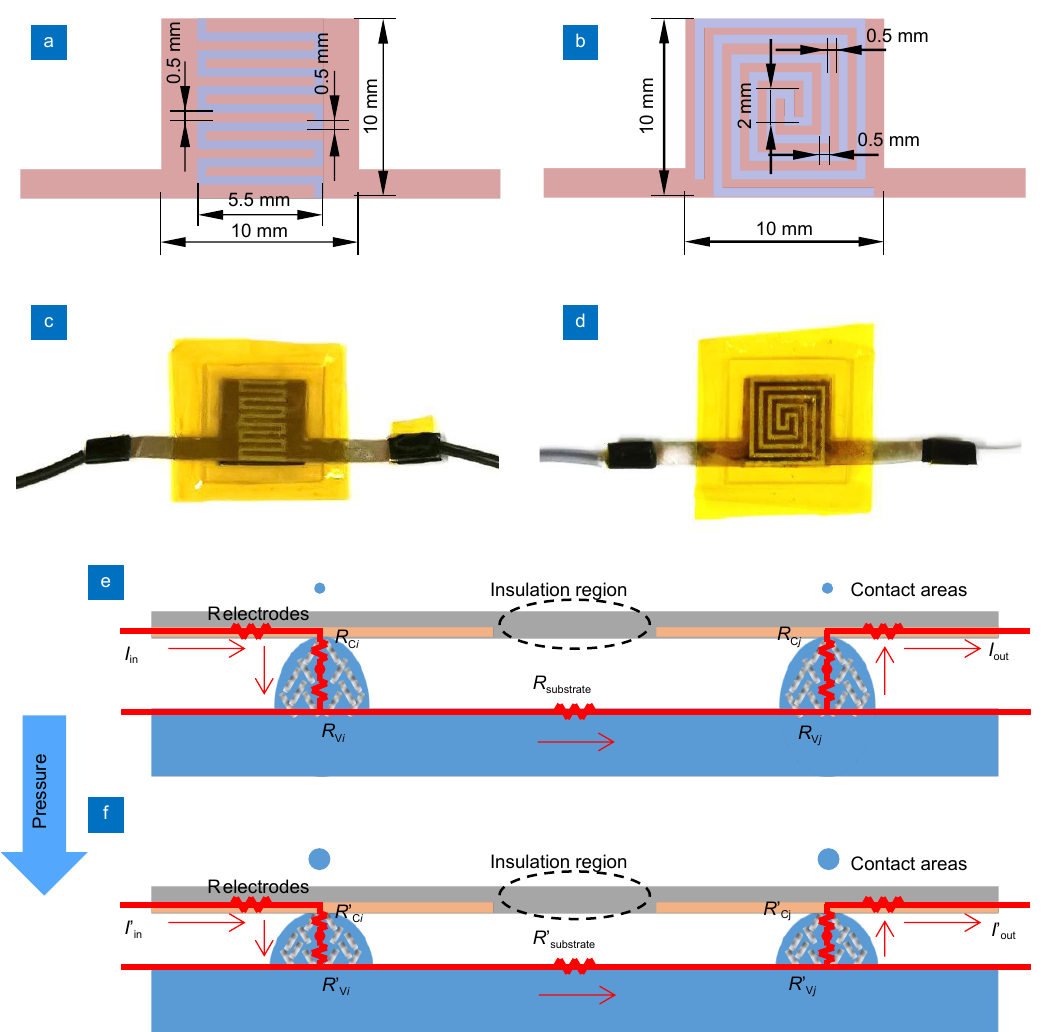
Fig. 5 | ( a ) Design of SLI interdigital electrodes. ( b ) Design of CRI interdigital electrodes. ( c ) Image of a sensor with SLI interdigital electrodes. ( d ) Image of a sensor with CRI interdigital electrodes. ( e , f ) Equivalent model of resistance in flexible piezoresistive sensors (e) without pressure, (f) under